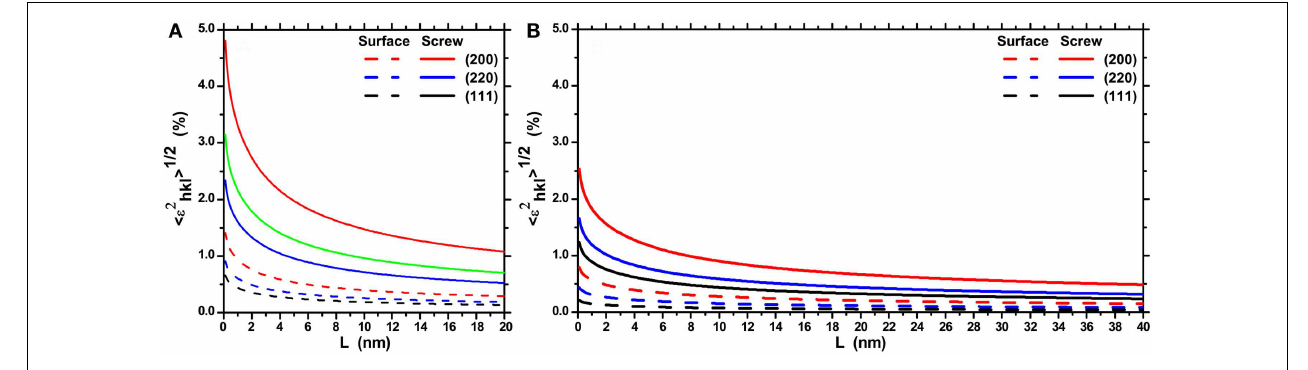
D = 40nm/ H = 28.7nm (B) .Trends refer to the dislocation strain (screw, line) and surface relaxation strain (surface, dash) along different crystallographic directions.